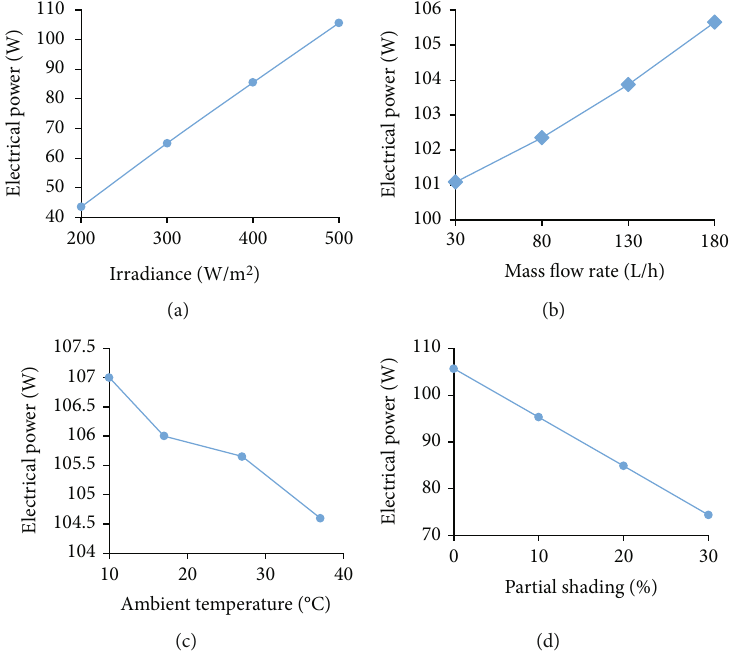
Figure 13: Outcome of (a) G , (b) V